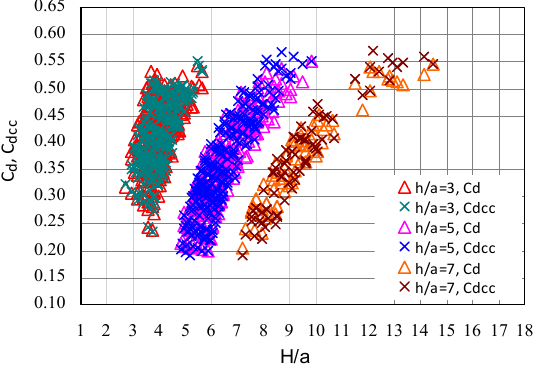
Figure 11. Discharge coefficients determined from measurements C d and calculated using relationship (5) with correction (13 b) for h/a ratios 3, 5, and 7 in the V2 case. The percentage deviation of the C d discharge coefficients determined directly by the